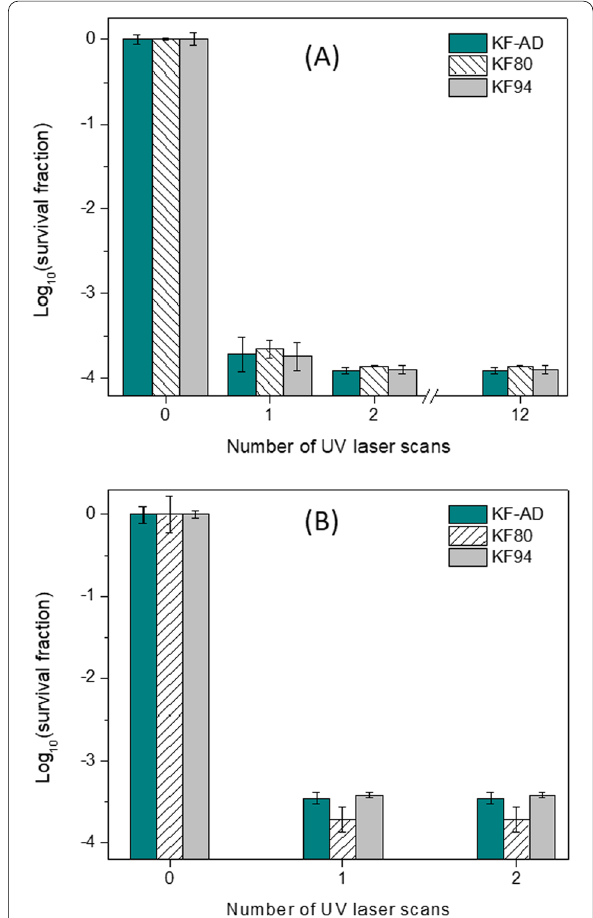
Fig. 4 LR values of A B. atrophaeus spores irradiated with 1, 2, and 12 UV laser and B E . coli irradiated with 1 and 2 UV